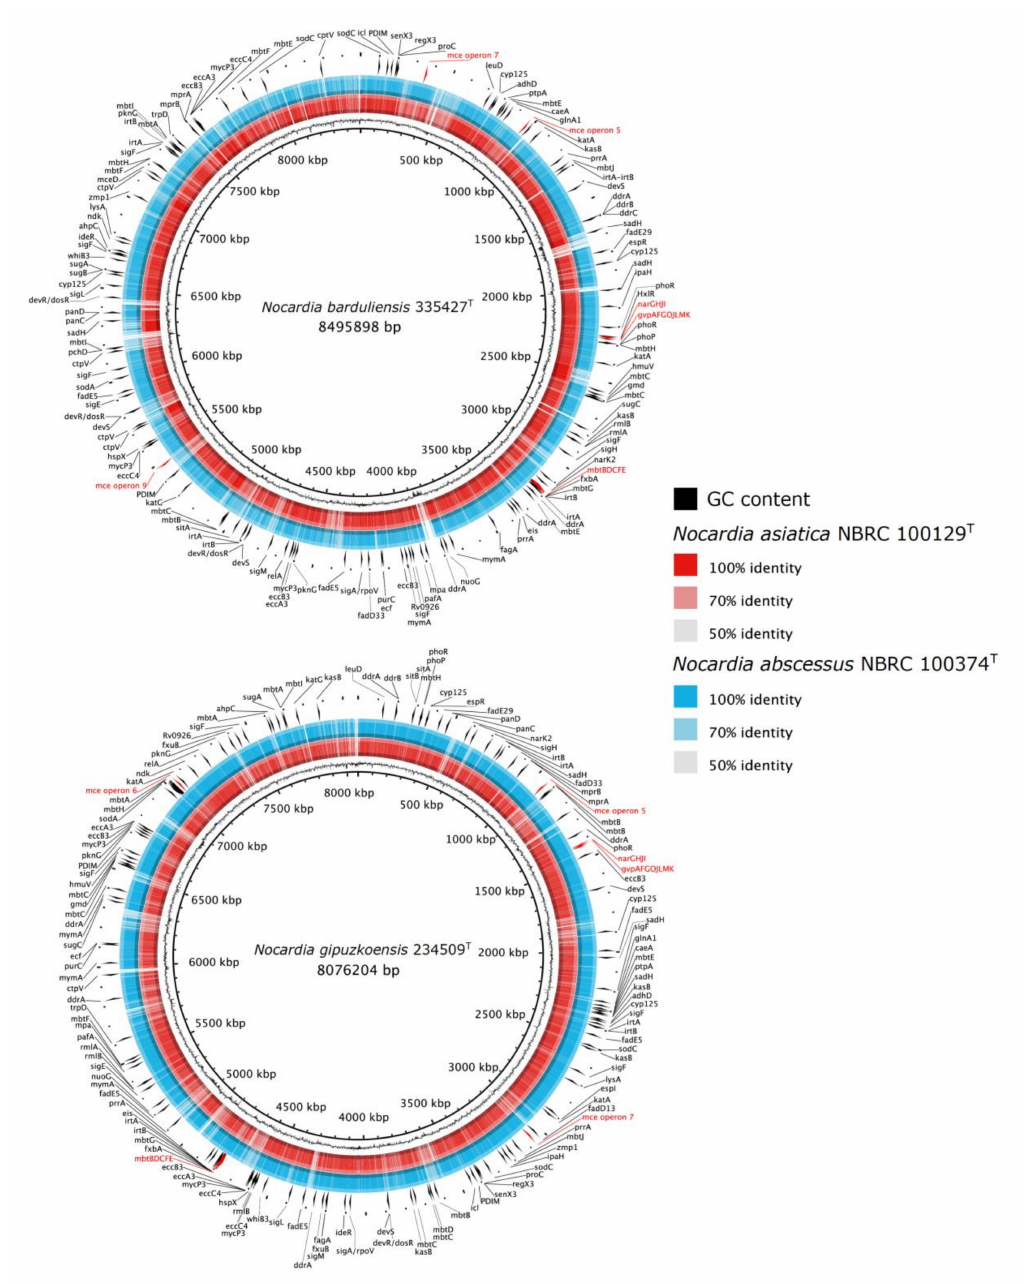
Figure 2. Comparative genomic map of the pathogenicity genes of isolates 335427 T and 234509 T genomes and their closest type strains. The circadian maps represent a BLASTN comparison of the genomes of isolates 335427 T and 234509 T (black inner rings) and its GC content (black frequency ring) with the genomes N. asiatica NBRC 100129 T (red ring) and N. abscessus NBRC 100374 T (blue ring). The pathogenicity genes are annotated with black labelled arrows and labels in red. The legends show the percentages of identity of genome